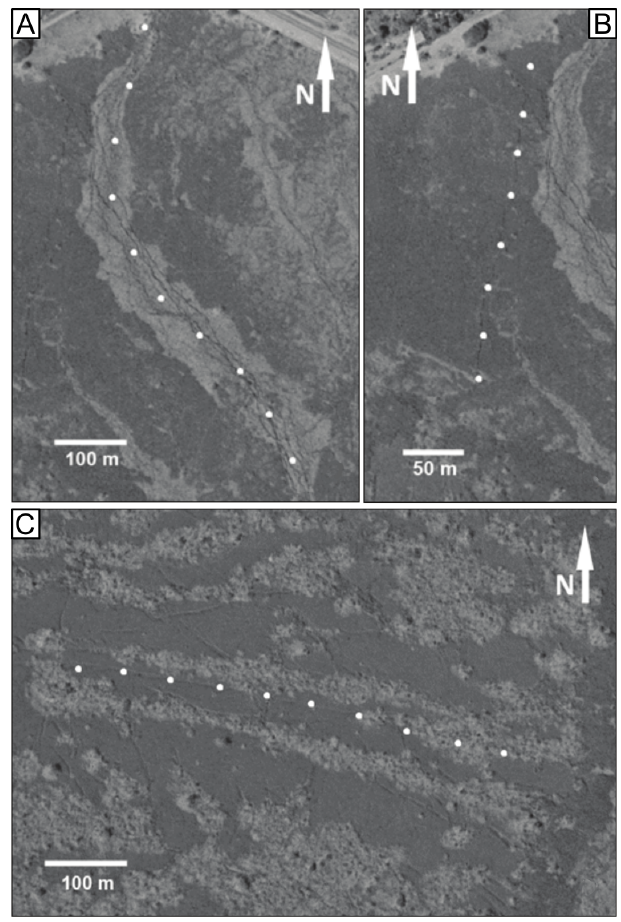
Figure 4: Aerial images of the Northwest fracture field (SC1 and O1 in Figure 2). White dots delineate [A] braided inflation fractures; [B] Cofradías fractures, and [C] double circular fault fractures (trees align along these subsided areas due to moisture